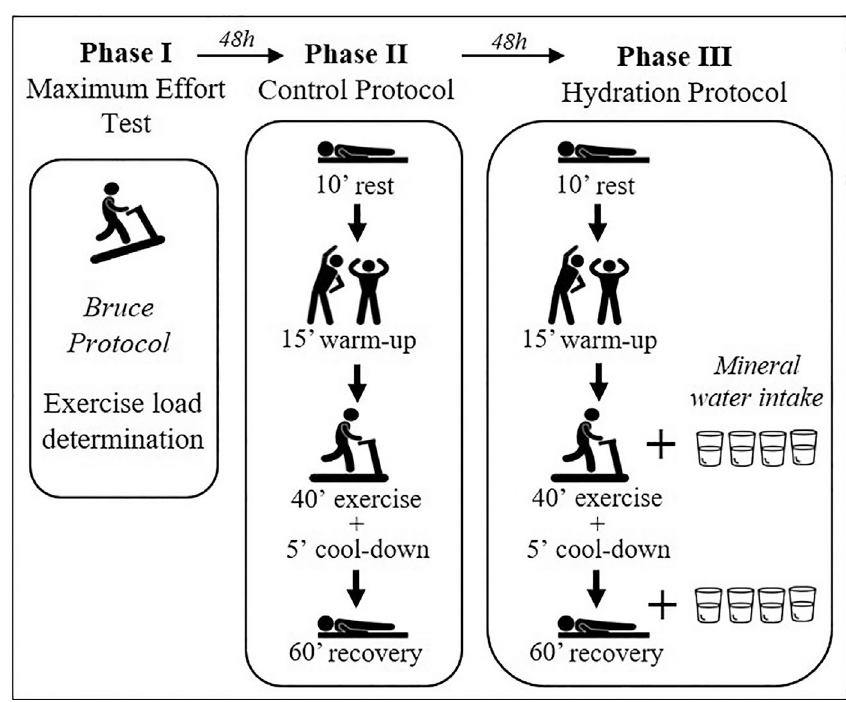
Figure 2 - Graph abstract of the experimental